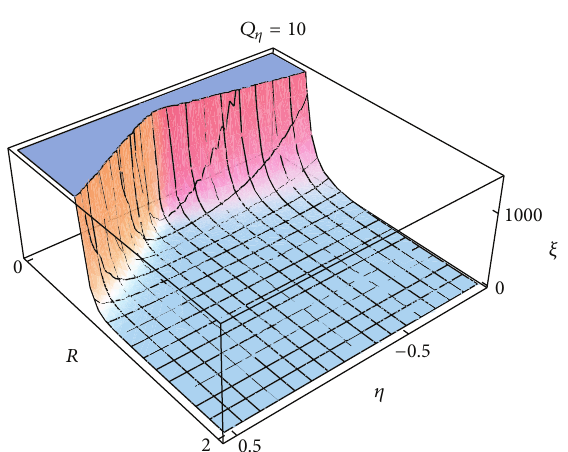
Figure 13: 4D Kretschmann invariant 𝜉 for 𝑄 𝜂 = 10 , for Λ = 0 .